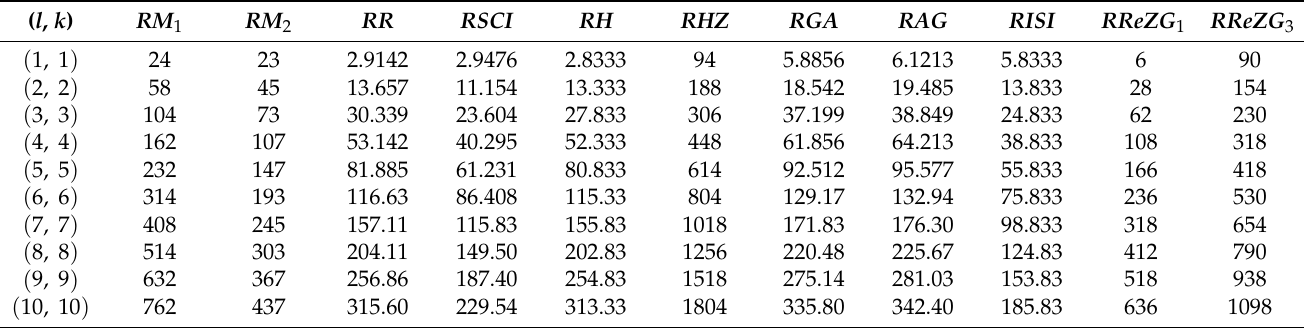
Table 1 Some reverse degree-based topological descriptors derived from the reverse general inverse sum indeg descriptor by assigning specific values to the parameters 𝑝 and 𝑞 .